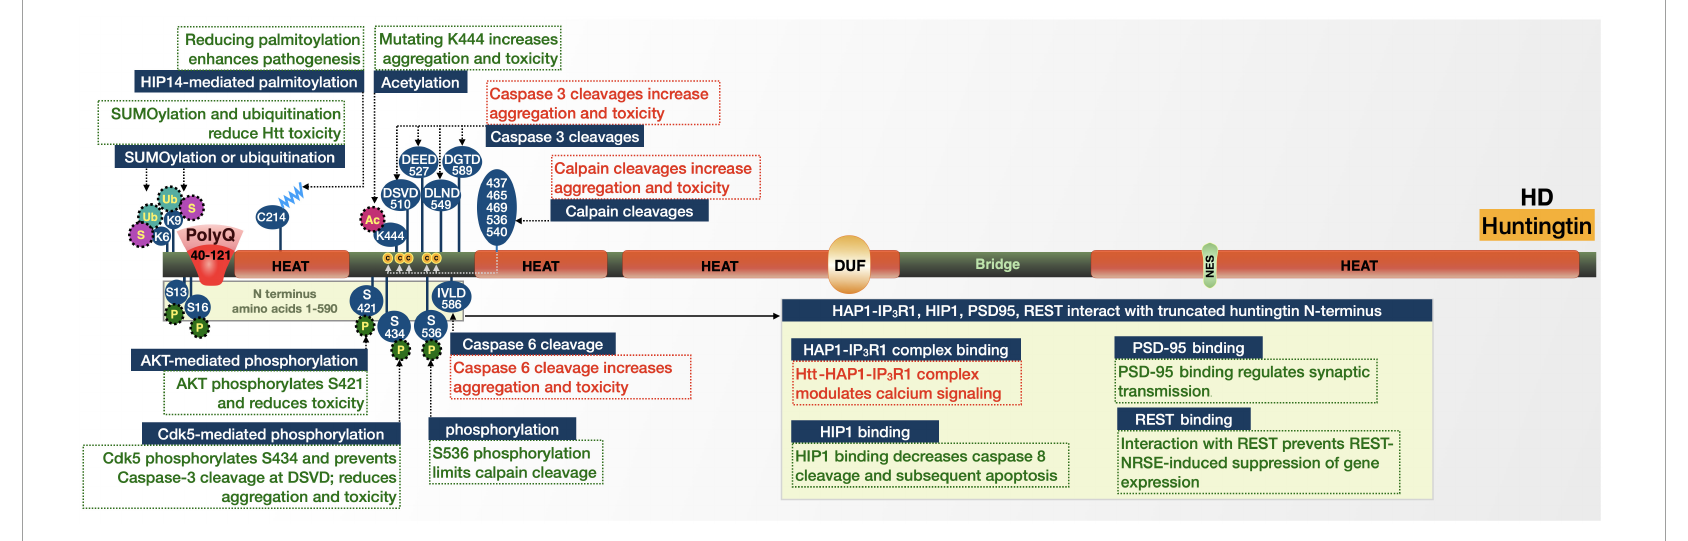
FIGURE3 Graphic representation of the HD protein, its domains, interactions, and modifications. Details are in the main